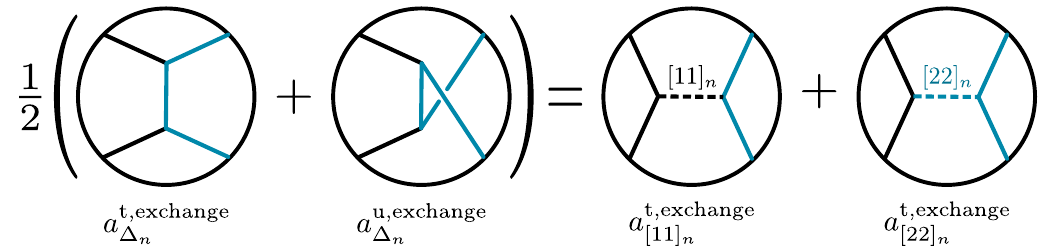
Figure 6 . The sum of t - and u -exchange Witten diagrams has an expansion in terms of purely parity even OPE